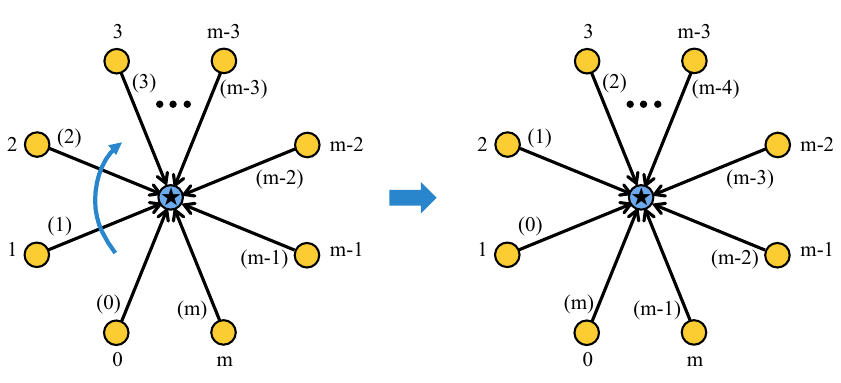
Figure 1. The transformation of (cid:13)avors upon a mutation on node ? can be implemented as a rotation of the degrees of the